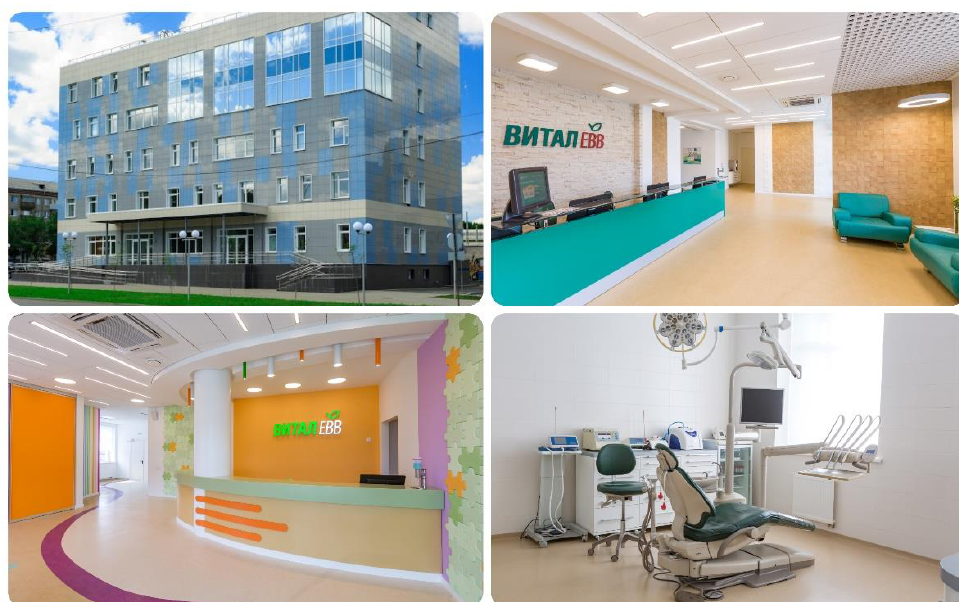
Figure 1. Environment of the private dental clinic.